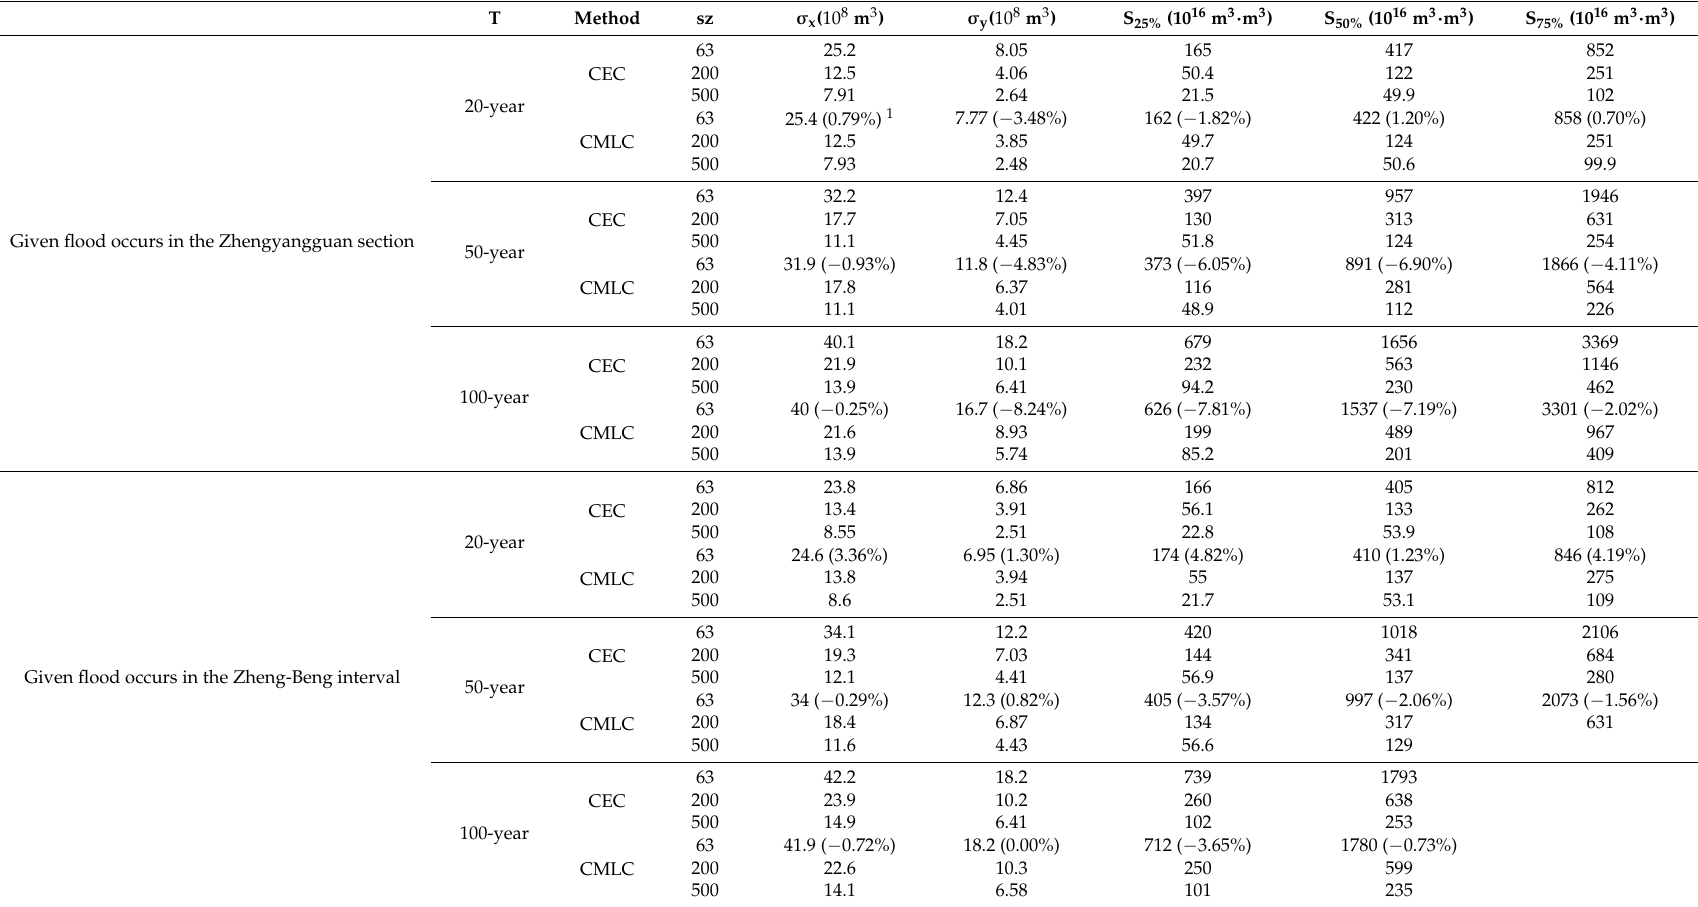
Table 7. Values of evaluation indexes for sampling uncertainty under different